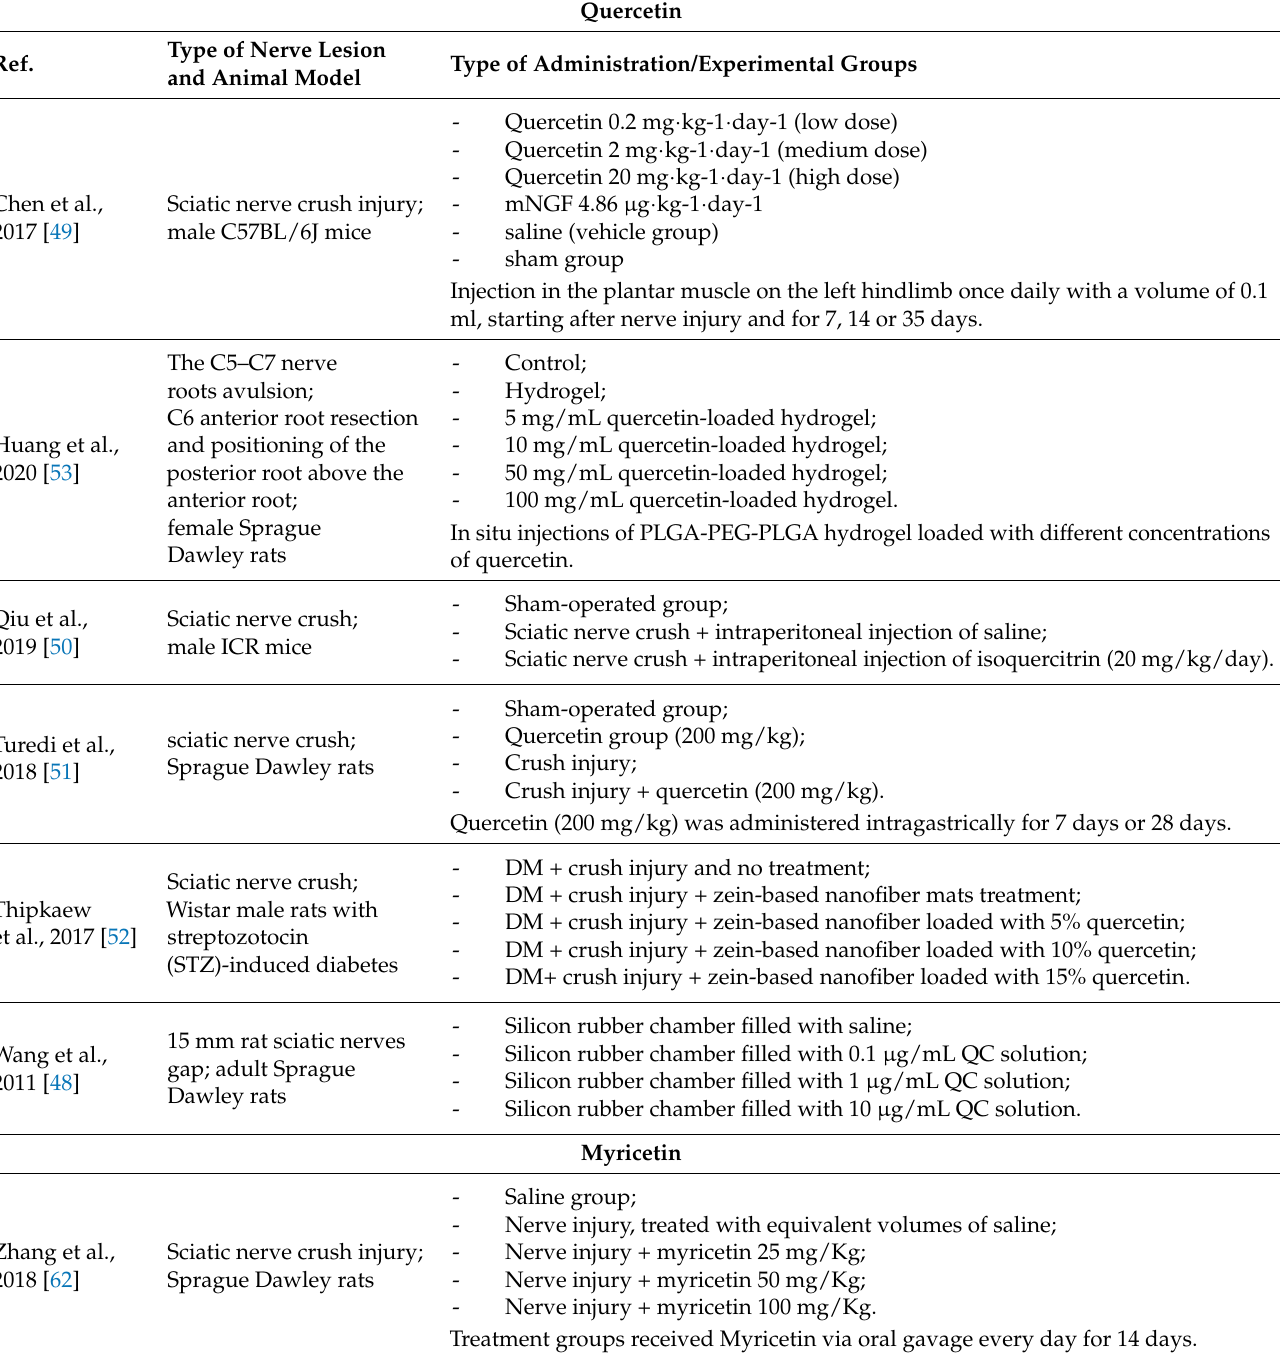
Table 3. Flavonols: Table showing the experimental method (type of nerve injury and animal model), the dose, and method of administration of quercetin and myricetin.